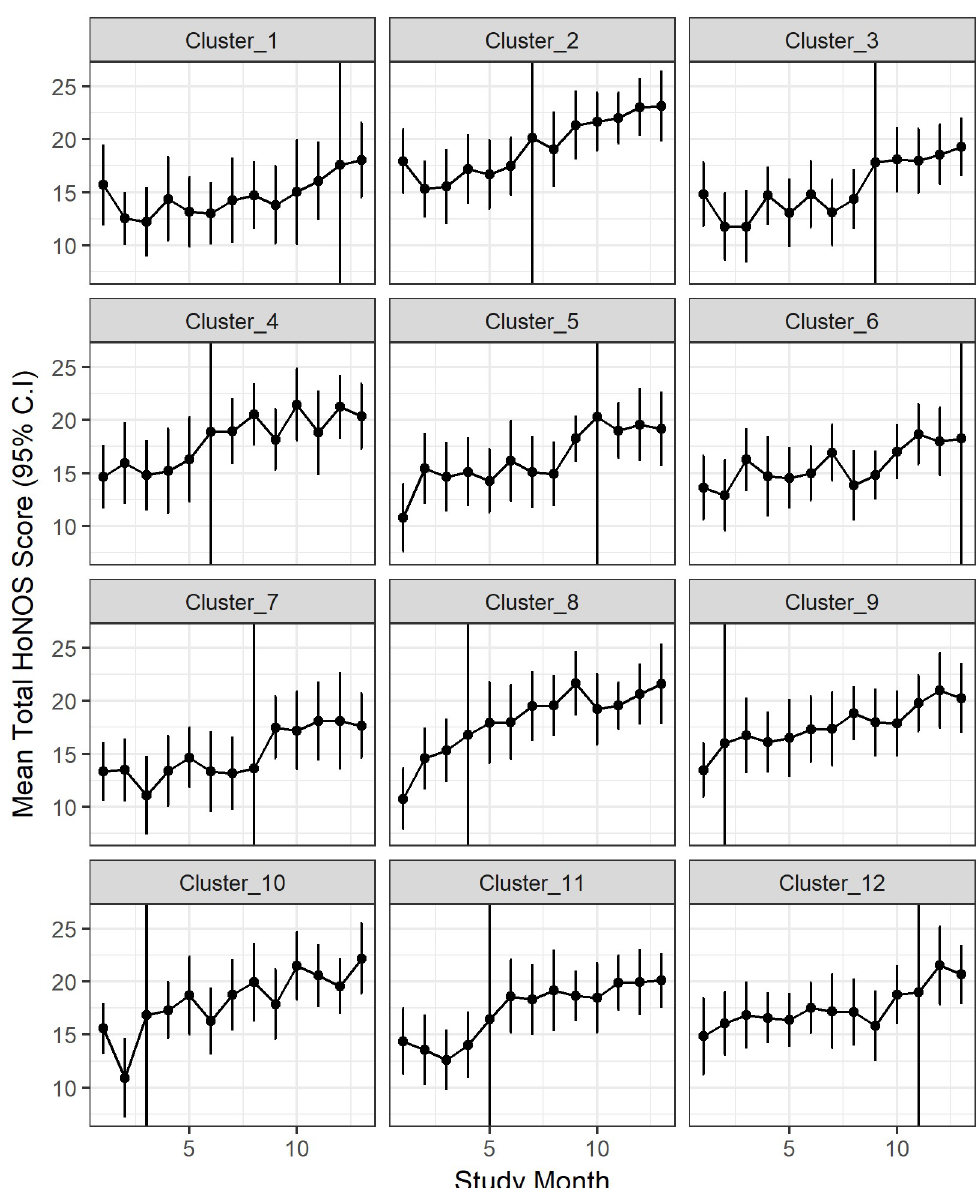
Fig 4. The simulated data under scenario D17: y ik ( t ) = 14 + 2 x tk + 0.25 t + 0.25 d tk . The means and 95% confidence intervals are plotted against the time since the intervention was introduced. Data to the left of the vertical line occurred before the intervention and data to the right after the intervention was